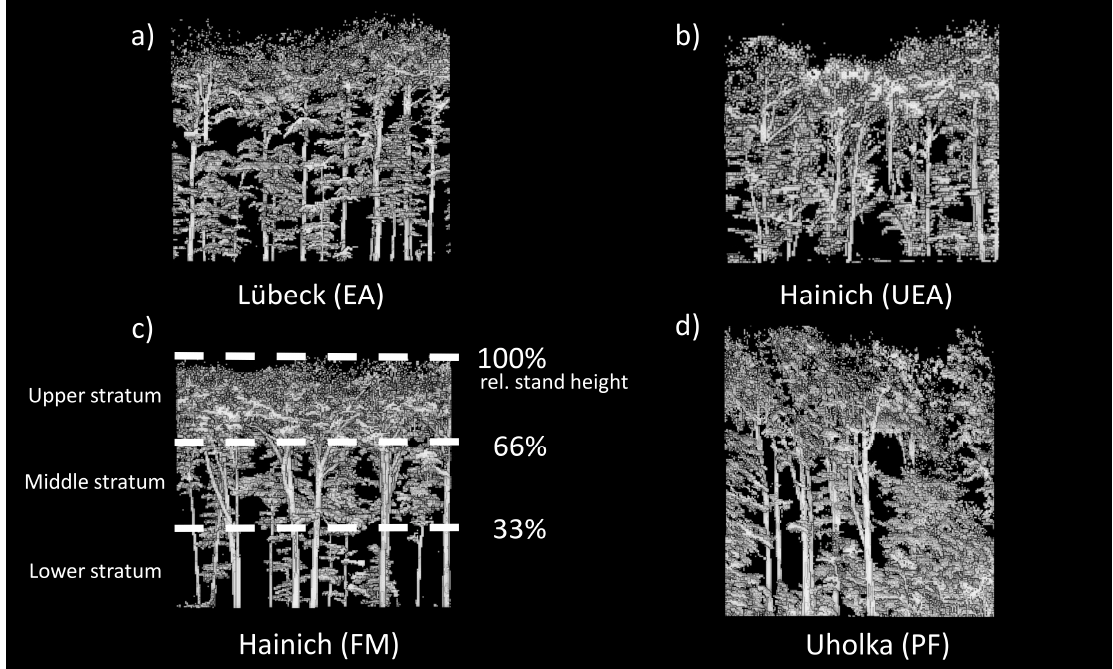
Figure 2. Side views of transects gained of voxelized (20 × 20 × 20 cm) 3D forest stands representing different forest types: An even-aged (EA) forest stand in Lübeck ( a ), a managed uneven-aged (UEA) and formerly managed (FM) forest stand in Hainich ( b , c ) and an unmanaged primary forest (PF) in Uholka ( d ). The relative stand height (100%) was defined as the uppermost stand stratum in which at least one voxel could be found. The three main forest strata were lower forest stratum ( ≤ 33% of the relative stand height), middle forest stratum (34%–66% of the relative stand height), and the upper forest stratum (67%–100% of relative stand height).